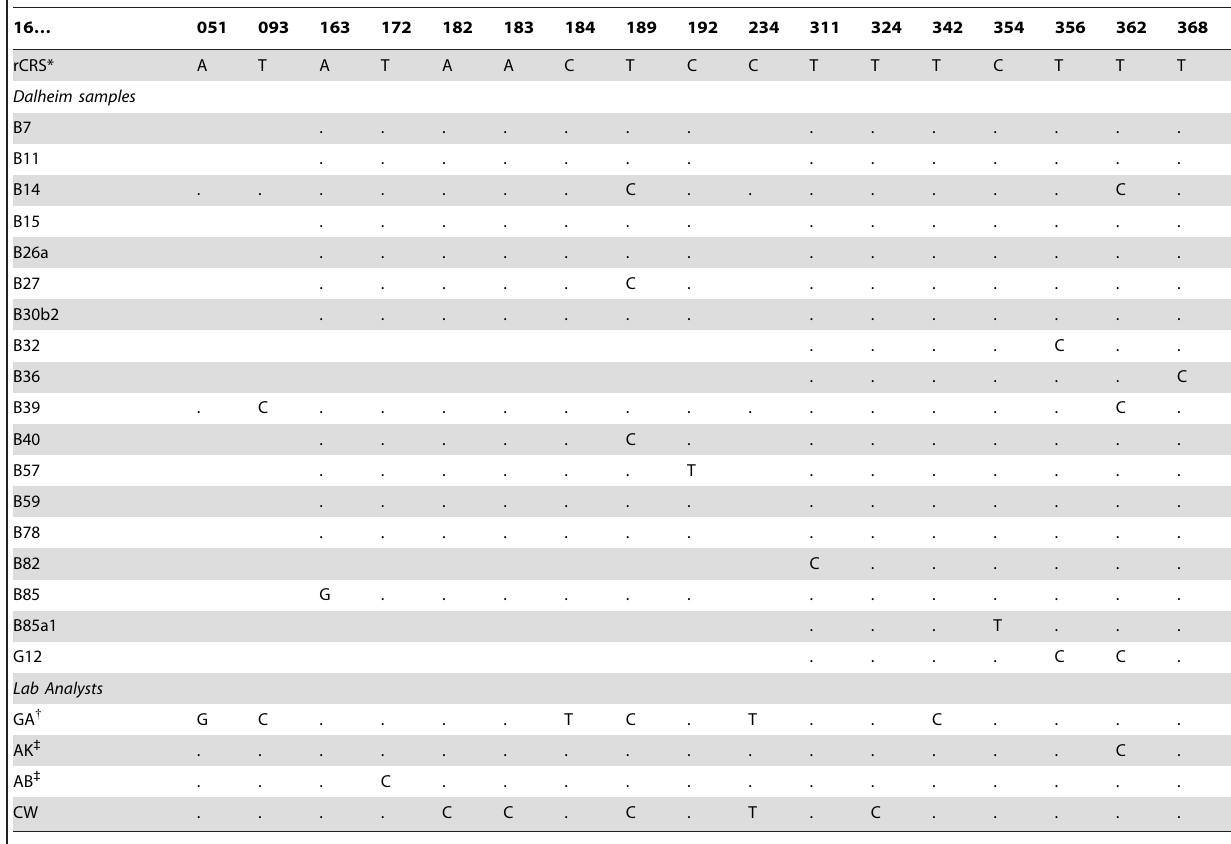
Table 1. Consensus mitochondrial HVRI data for Dalheim human samples and laboratory